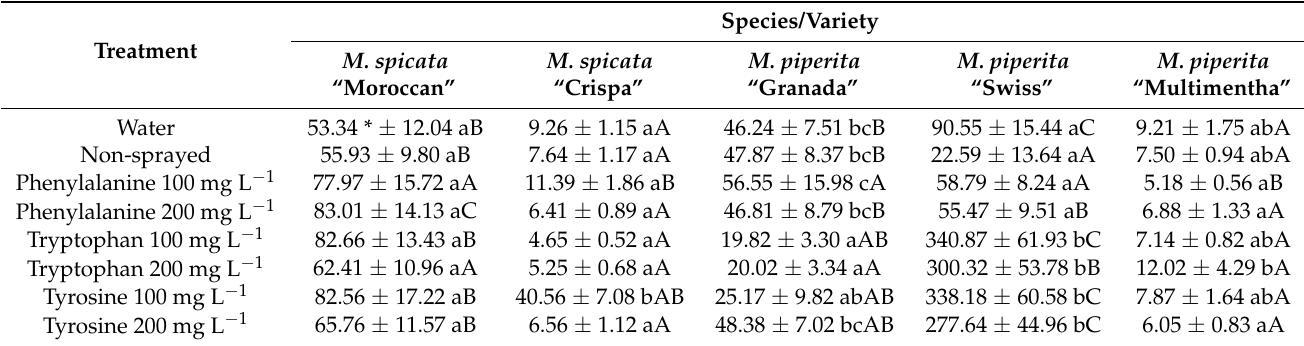
Table 4. Caffeic acid content in mints influenced by foliar application of amino acids, mg 100 g − 1 DM in 2017–2018.